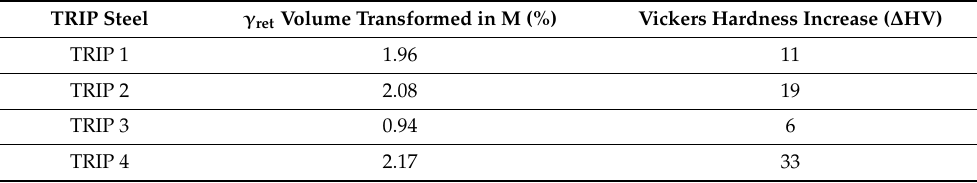
Table 8. Correlation of the hardness increase with the martensite fraction resulting from the impact bending